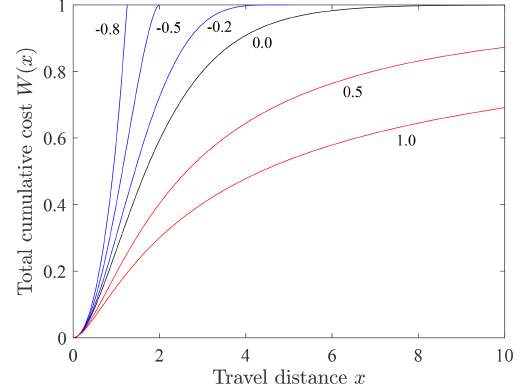
Figure B1. Plot of total cumulative cost W ( x ) versus travel dis- tance x for different values of the shape parameter A representing net cooling ( A < 0, blue), isothermal conditions ( A = 0, black) and net heating ( A > 0,